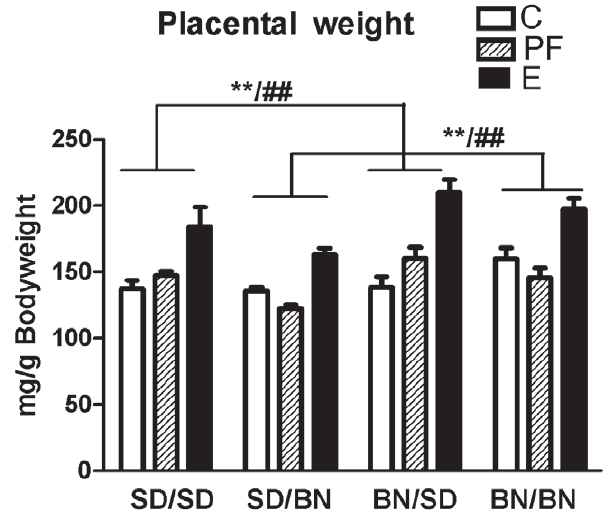
Figure 4. Pair-feeding effect on placental weight depends on strain while alcohol effect does not. Placental weight of C, PF, and E fetuses (SD/SD, SD/BN, BN/SD, and BN/BN where maternal strain is first) on G21. Placental weights were normalized to fetal bodyweights and means from individual litters were used to calculate group means 6 SEM as shown. There was no effect of fetal sex, so male and female data were pooled and analyzed by three-way ANOVA. Placentae of BN mothers were heavier than SD (F [1, 85]=17.5, P , 0.001). Pair fed placentae of SD fathers were heavier than controls, while pair fed placentae of BN fathers weighed less (paternal strain x diet F [2, 85]=3.8, P =0.03). In contrast, alcohol exposure increased placental weight regardless of strain (F [2, 85]=38.0, P , 0.001). Result of Bonferroni post-hoc test is shown: **E vs. C with SD or BN father regardless of maternal strain ( P , 0.01). ## E vs. PF with SD or BN father regardless of maternal strain ( P , 0.01).